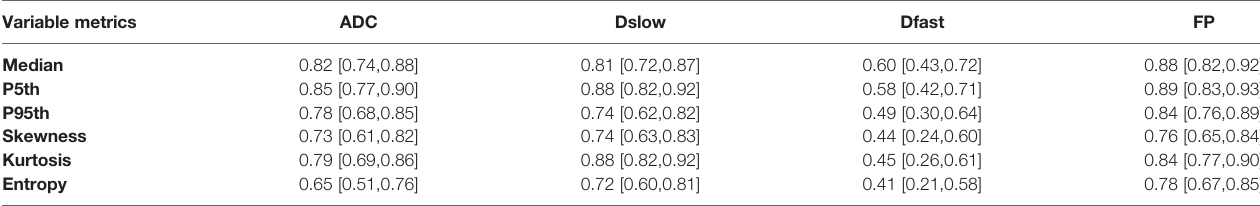
Data are interobserver correlation coef fi cients, with 95% con fi dence intervals in brackets. ADC, apparent diffusion coef fi cient; Dslow, pure molecular-based diffusion coef fi cient; Dfast, pseudo-diffusion coef fi cient; FP, pseudo-diffusion factor given as a percentage; P5th, 5th percentile; and P95th, 95th